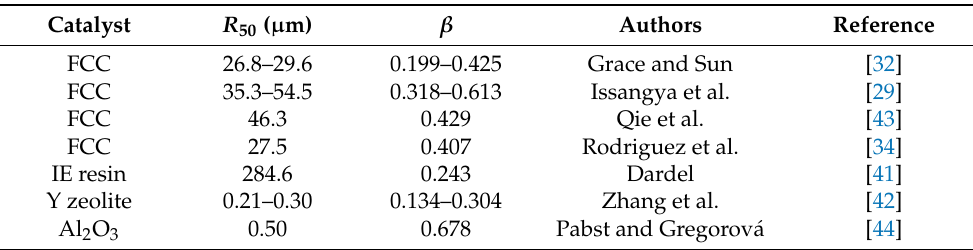
Table 1. Parameters of the theoretical log-normal volume PSD in different samples of catalysts calculated from various